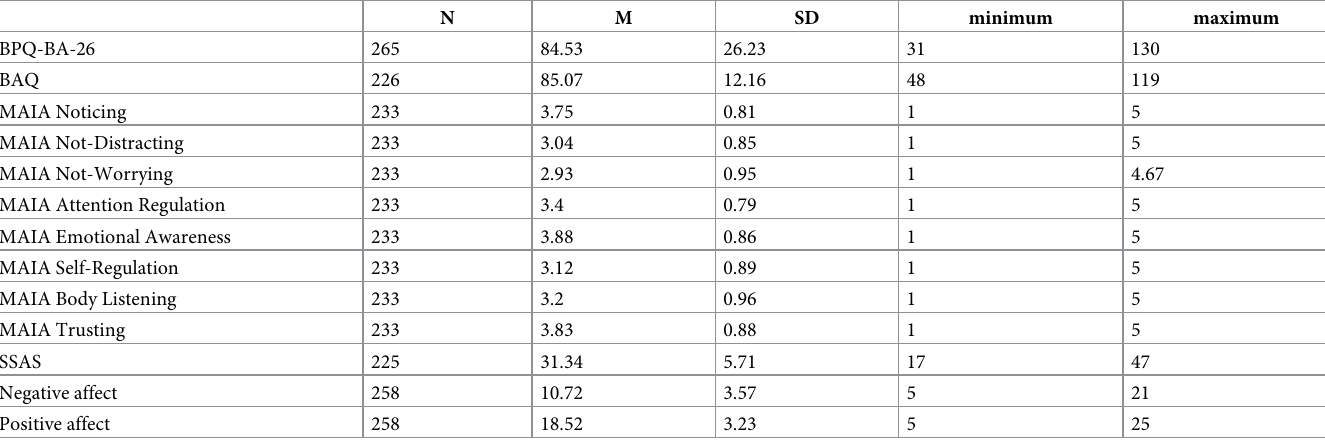
Table 1. Descriptive statistics of the assessed variables.